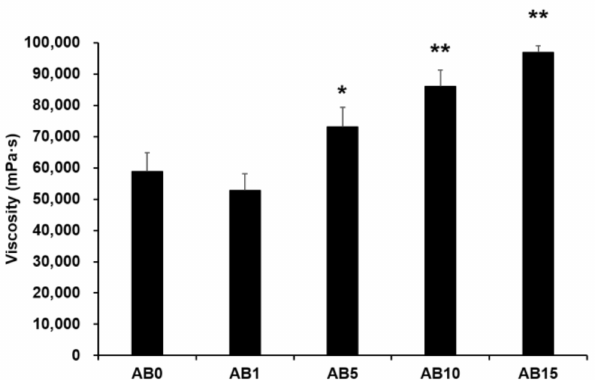
Figure 5. Viscosity of the elastic artificial skin. Results are expressed as the means ± standard deviations of three independent experiments ( n = 3). AB0: Non-SLN artificial skin; AB1: Artificial skin with 1% SLNs; AB5: Artificial skin with 5% SLNs; AB10: The artificial skin with 10% SLNs; AB15: Artificial skin with 15% SLNs. Statistical significance of the difference in viscosity between the formulation without SLNs, and formulations with SLNs is indicated by either a single asterisk ( p < 0.05) or double asterisks ( p < 0.01). SLNs, solid lipid